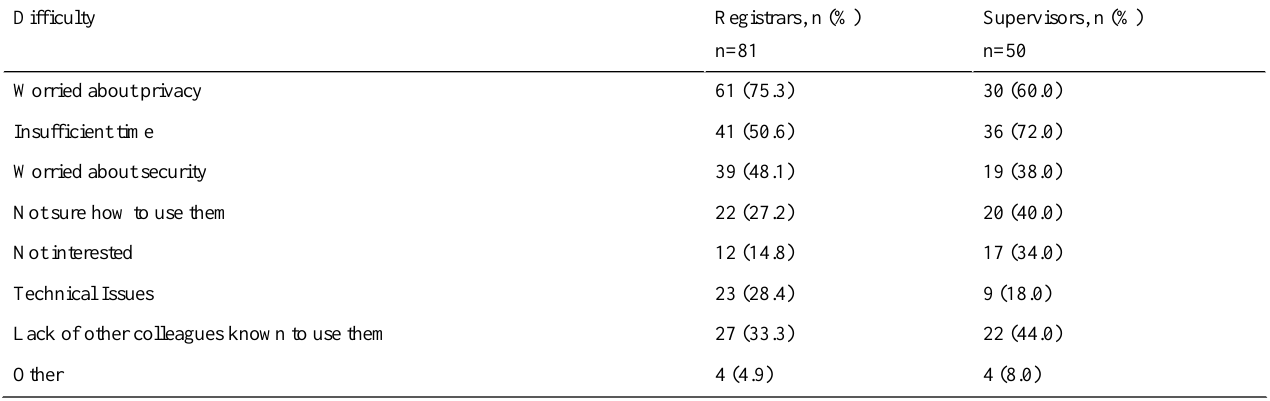
Table 4. Perceived difficulties in using online social networks for professional purposes.